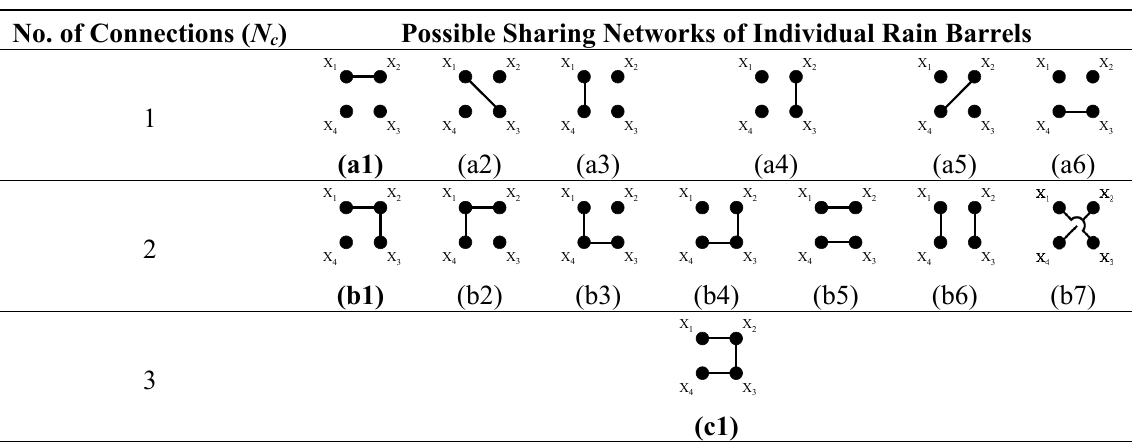
Table 3. Possible and selected rain barrel sharing networks in this study.